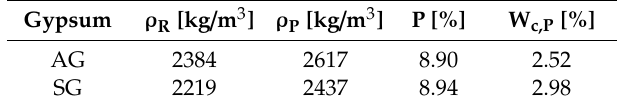
Table 4. Density and porosity of Moroccan Agadir (AG) and Safi (SG) samples of rock and powder.